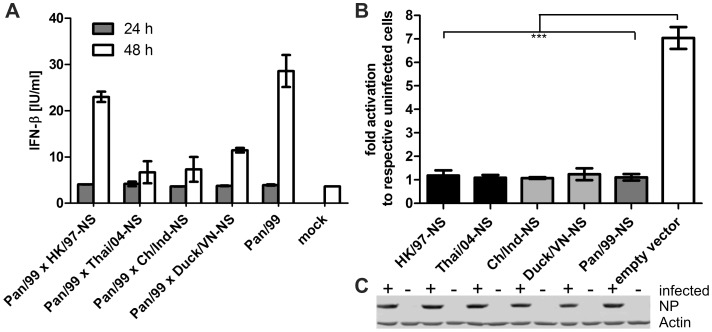
H5N1 NS1 proteins inhibit the induction of type I IFN in human cells.(A) IFN-β concentrations of supernatants sampled from A549 cell cultures infected with the Pan99 WT and different NS reassortant viruses (H3N2) (MOI = 0.01) at 24 and 48 hrs p.i., (N≥2+/–SEM). (B) Human 293T cells were co-transfected with plasmids expressing the H5N1- or Pan/99 (H3N2)-derived NS segments or empty vector, the human IFN-β promoter reporter plasmid p125-Luc and pRL-TK-Luc to control for transfection efficiency. Subsequently, cells were infected for 16 h with Pan-delNS1 to stimulate the IFN-β promoter before luciferase reporter activity was determined in cell lysates. IFN-β promoter activation in infected cells is shown as x-fold stimulation of firefly luciferase activity compared to transfected and mock infected cells. Mean data of three independent experiments is shown +/– SD. (C) Immunblot detection of viral NP after Pan-delNS1 (H3N2) infection confirmed equal stimulation of the transfected cells analyzed in panel B.